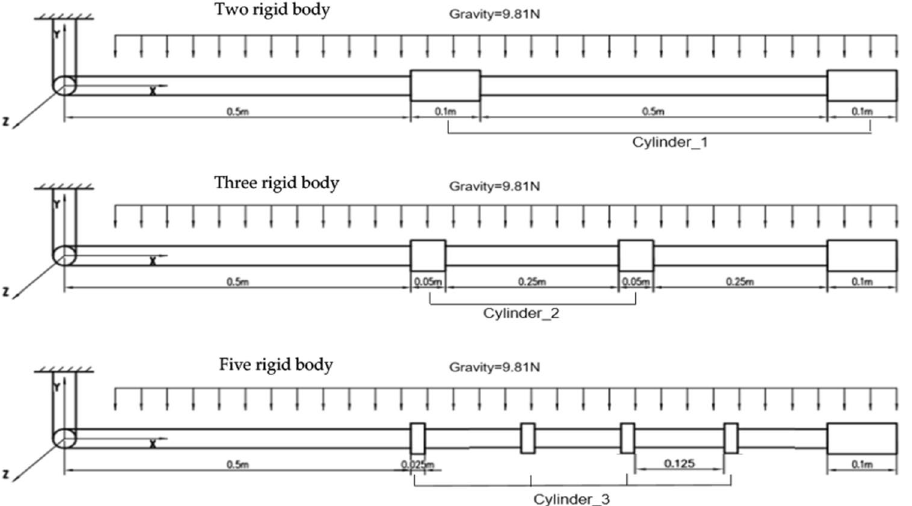
Figure 11. Schematic diagram of different patterns of distribution of rigid